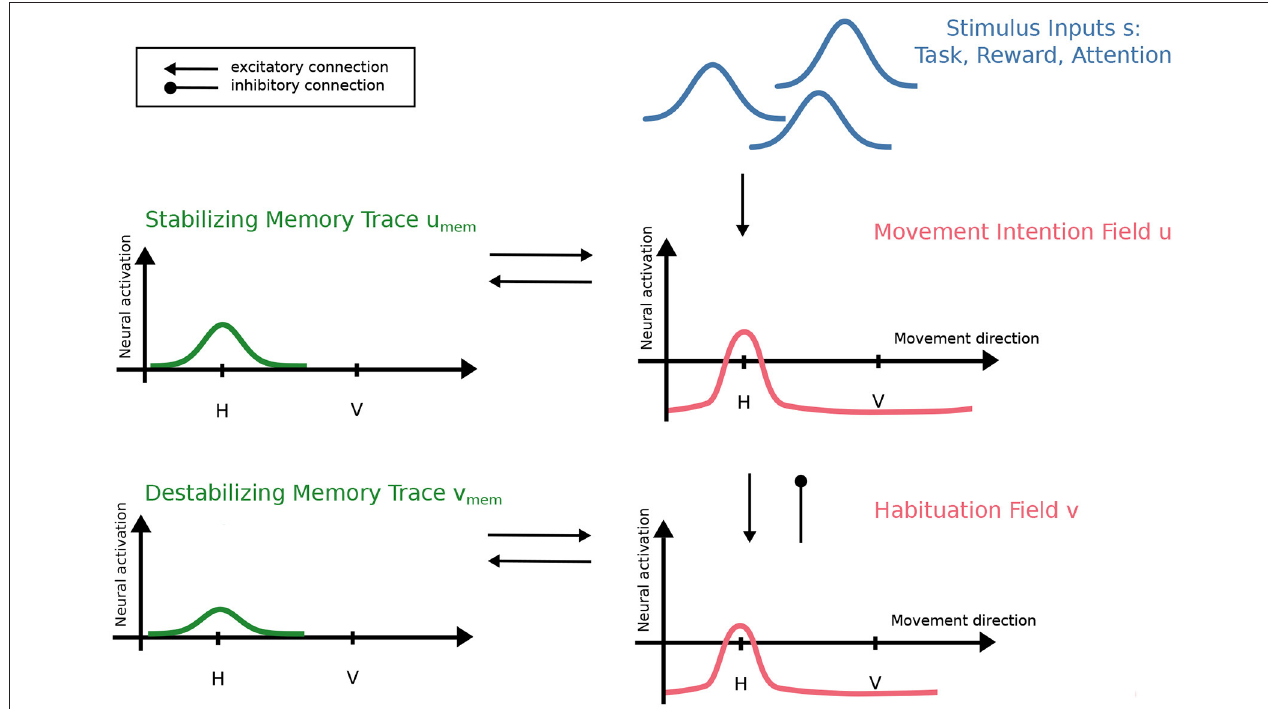
FIGURE 4 | DFT model of motor habituation. The intention field, u , receives stimulus inputs, s , that models the visual perception of the box and lever, the perception of rewarding outcomes, or stimulation by a parent. The intention field provides input to the habituation field, v , which in turn inhibits the intention field. Both fields are defined over the movement direction, x , sampled at horizontal (H) and vertical (V) movement directions in the experiment. A supra-threshold peak at a location, x , in the intention field indicates that a movement in that direction is being generated. Memory traces reflect the recent history of supra-threshold activation in both fields and provide input back to the fields. They facilitate peak formation and, thus, account for the stabilization and destabilization of movement